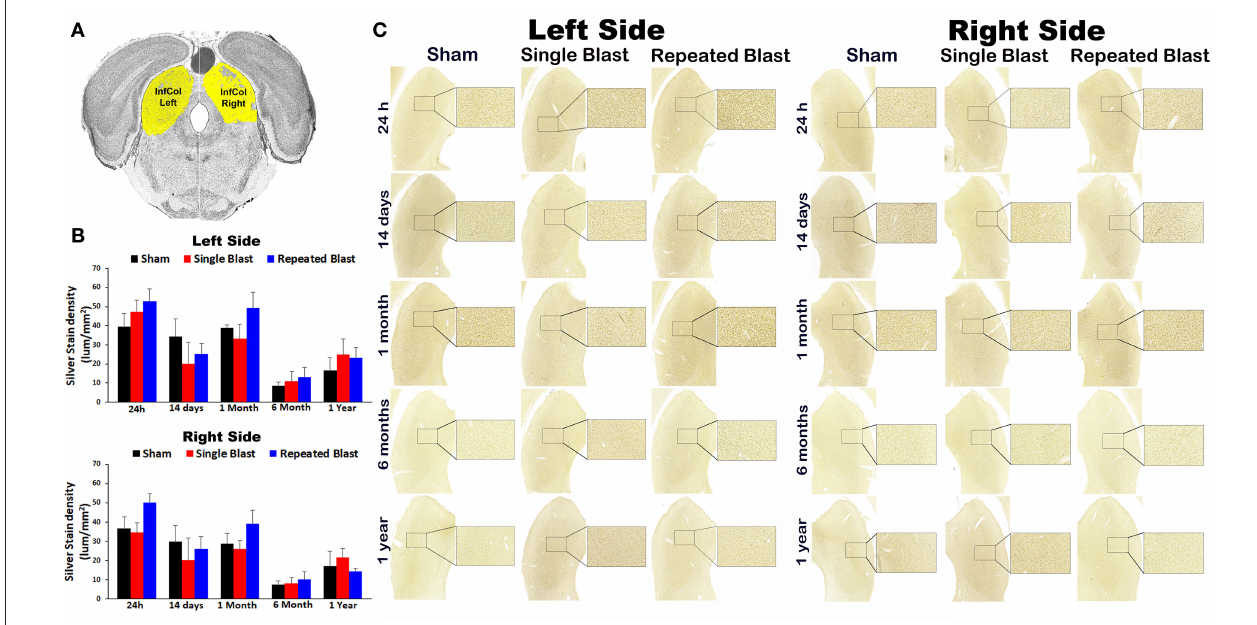
FIGURE 4 | Silver staining in the left and right inferior colliculus. (A) Inferior colliculus (InfCol) region selected using rat brain atlas for analysis. (B) Graphics showing densitometry analysis from the left and right silver-stained InfCol regions at different intervals post-blast exposures. (C) Representative silver-stained images from left and right InfCol regions at different intervals after single and tightly coupled repeated blasts. Portions of sections inside rectangles are shown at higher magnification on the right. Values are expressed as mean ± SEM. Density values of single and repeated blast-exposed groups were compared to the respective sham controls ( p > 0.05, ANOVA; normal distribution; n = 4–6).